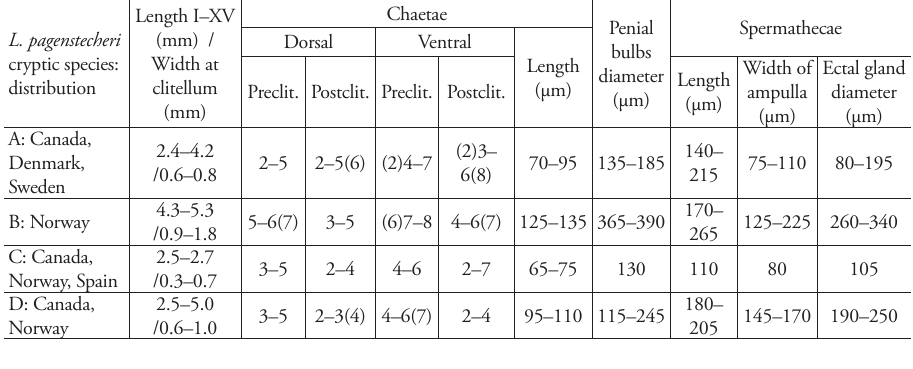
Table 2. Comparison of selected measured traits from the four possibly cryptic species of L. pagenstecheri , as well as their known geographical distribution. As our specimens were amputated for the extraction of DNA we could only compare the size of the first 15